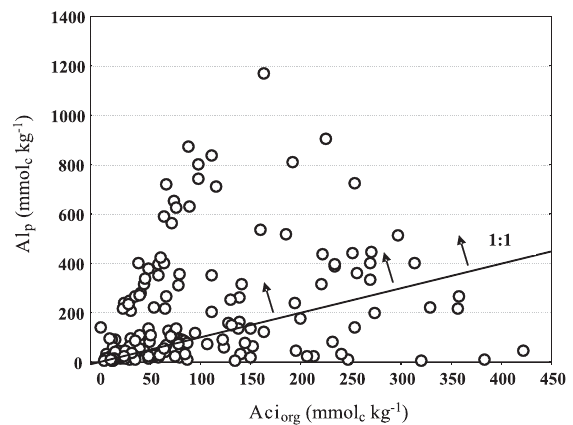
Figura 2. Relação entre o Al extraído com pirofosfato (Al ) e o conteúdo de acidez orgânica (Aci p estimada para todos os horizontes e solos estudados, com valores de Al (Corg) detectáveis pelos respectivos métodos analíticos.